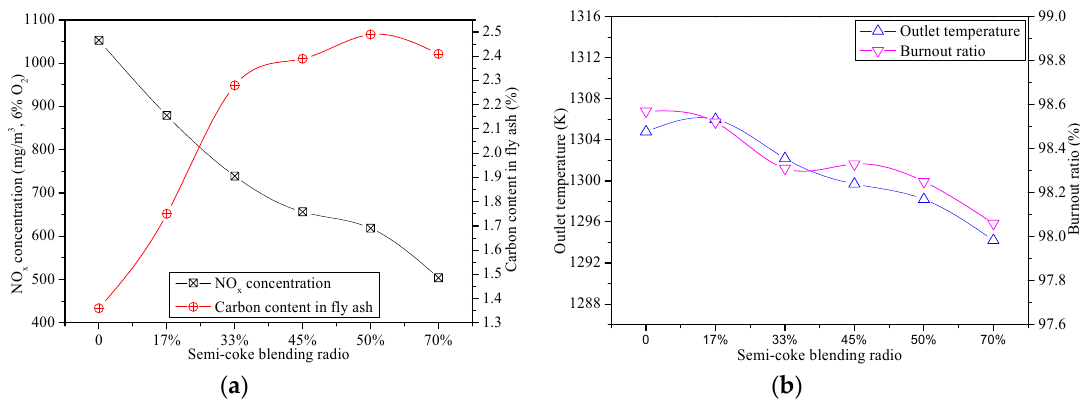
Figure 7. Some indicators at the furnace outlet for out-furnace blending combustion under various semi-coke blending ratios; ( a ) the NO x concentration and carbon content in fly ash; ( b ) the outlet temperature and burnout ratio.